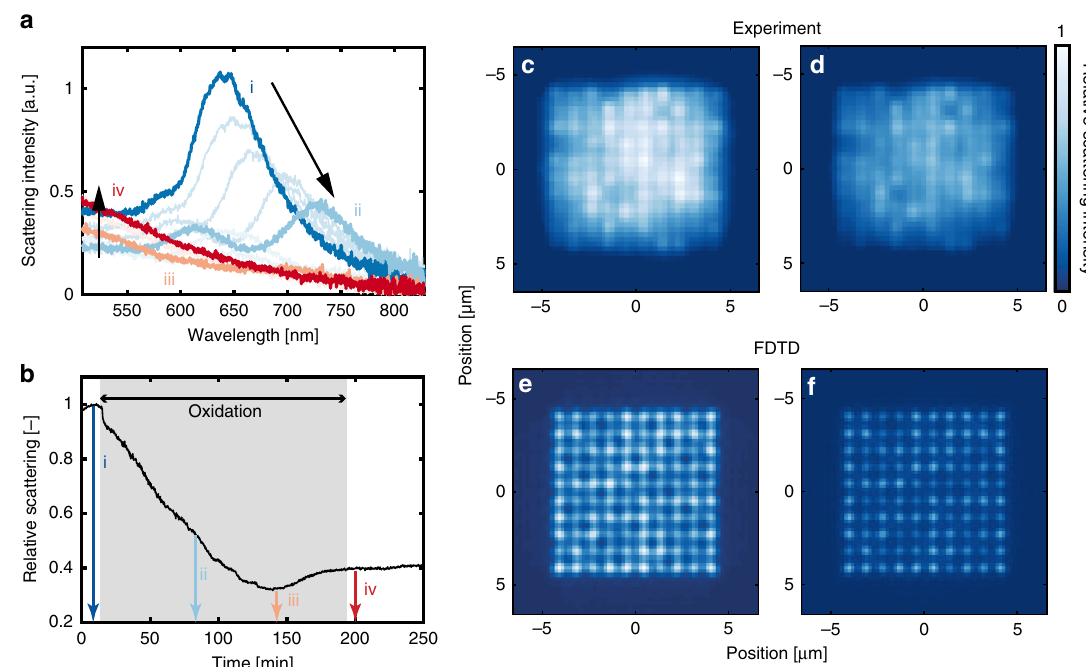
Fig. 3 Optical response of individual Cu nanoparticles during oxidation. a Scattering spectra from a Cu nanoparticle during oxidation in 0.1% O 2 in Ar carrier gas at 200 °C. Four stages of oxidation are highlighted: (i) metallic, (ii, iii) partly oxidized, (iv) bulk oxidized. The arrows indicate how the spectra evolve when going from stage i to ii (right arrow) and from stage iii to iv (left arrow). b Total scattering intensity integrated across the entire wavelength range of 500 – 850 nm for the same particle as in ( a ) during oxidation in O 2 (shaded area). The three colored arrows correspond to the time of the spectral snapshots presented in ( a ). c , d Dark- fi eld scattering microscopy image of a 100 Cu nanoparticle array before ( c ) and after ( d ) oxidation. e , f FDTD simulated intensity pro fi les of a 100 Cu nanoparticle array with all particles simulated as metallic Cu ( e ) or Cu 2 O ( f ). The radius of the simulated Cu nanoparticles was randomized (±5 nm) to illustrate the effect of a small size difference on the intensity pro fi les. The images in ( c – f ) have been normalized to the same scattering intensity levels.